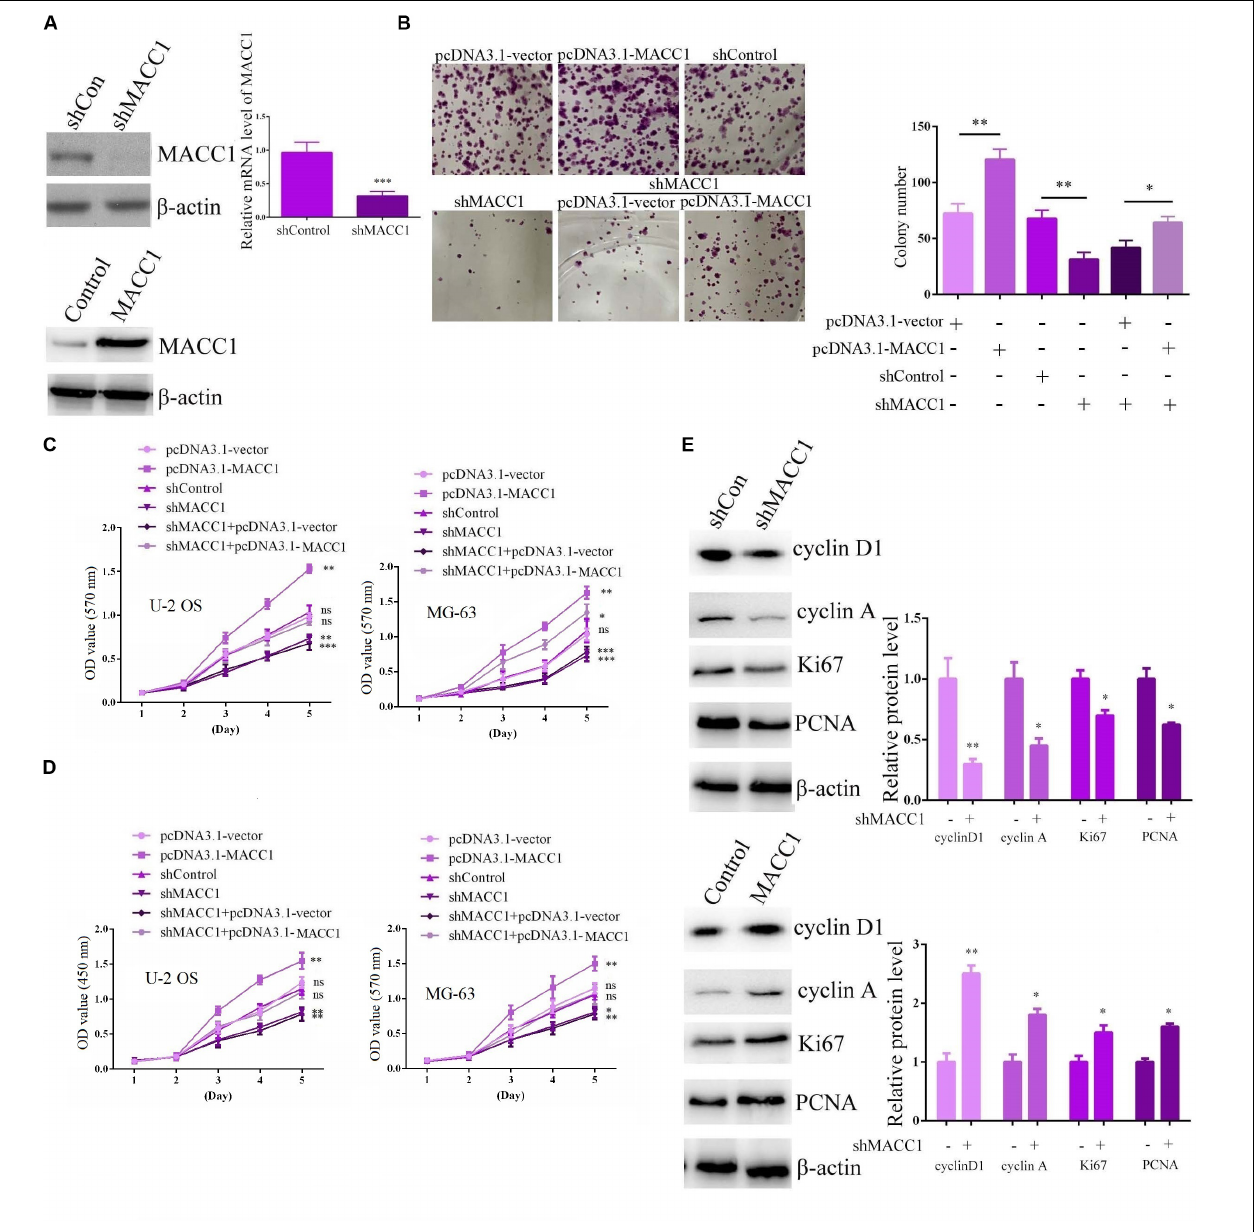
FIGURE 2 | MACC1 promotes the proliferation of osteosarcoma cells in vitro . (A) Immunoblot assays and qPCR were performed to measure the protein expression of MACC1 in osteosarcoma (OS) cells following transfection with the indicated plasmids. (B) Colony formation assays were performed to evaluate the difference in proliferative ability between OS cells in the indicated groups. (C) MTT assays were performed to detect the proliferation level in cells transfected with the indicated plasmids. (D) CCK-8 assays were performed to detect the proliferation level in cells transfected with the indicated plasmids. (E) Immunoblot assays were performed to analyze the expression of Ki-67, PCNA, cyclin D2, and cyclin A in OS cells transfected with the indicated plasmids. Quantification of relative protein level were displayed. The results are presented as means ± SEM; ∗ p < 0.05, ∗∗ p < 0.01, and ∗∗∗ p < 0.001.